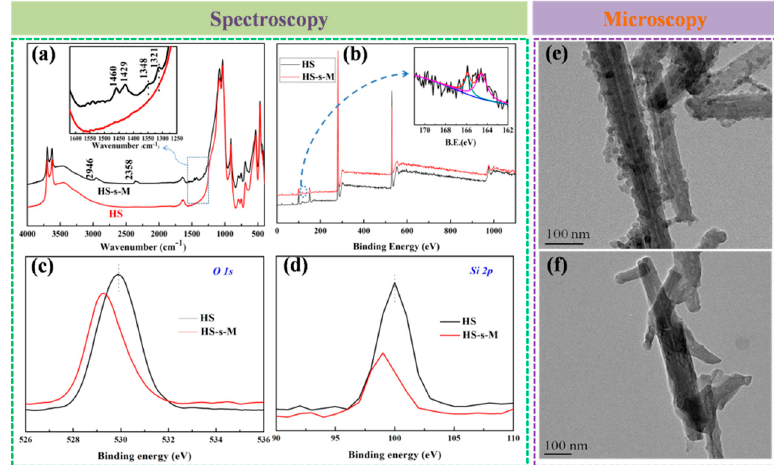
Figure 2. FTIR spectra ( a ) and XPS spectra ( b ) of HS and HS-s-M, High-resolution O 1s ( c ) and Si 2p ( d ) XPS spectra of HS and HS-s-M, TEM images of HS ( e ) and HS-s-M ( f ) (the insets in ( a ) and ( b ) are a higher magnification image of FTIR and high-resolution S 2p XPS spectra, respectively).